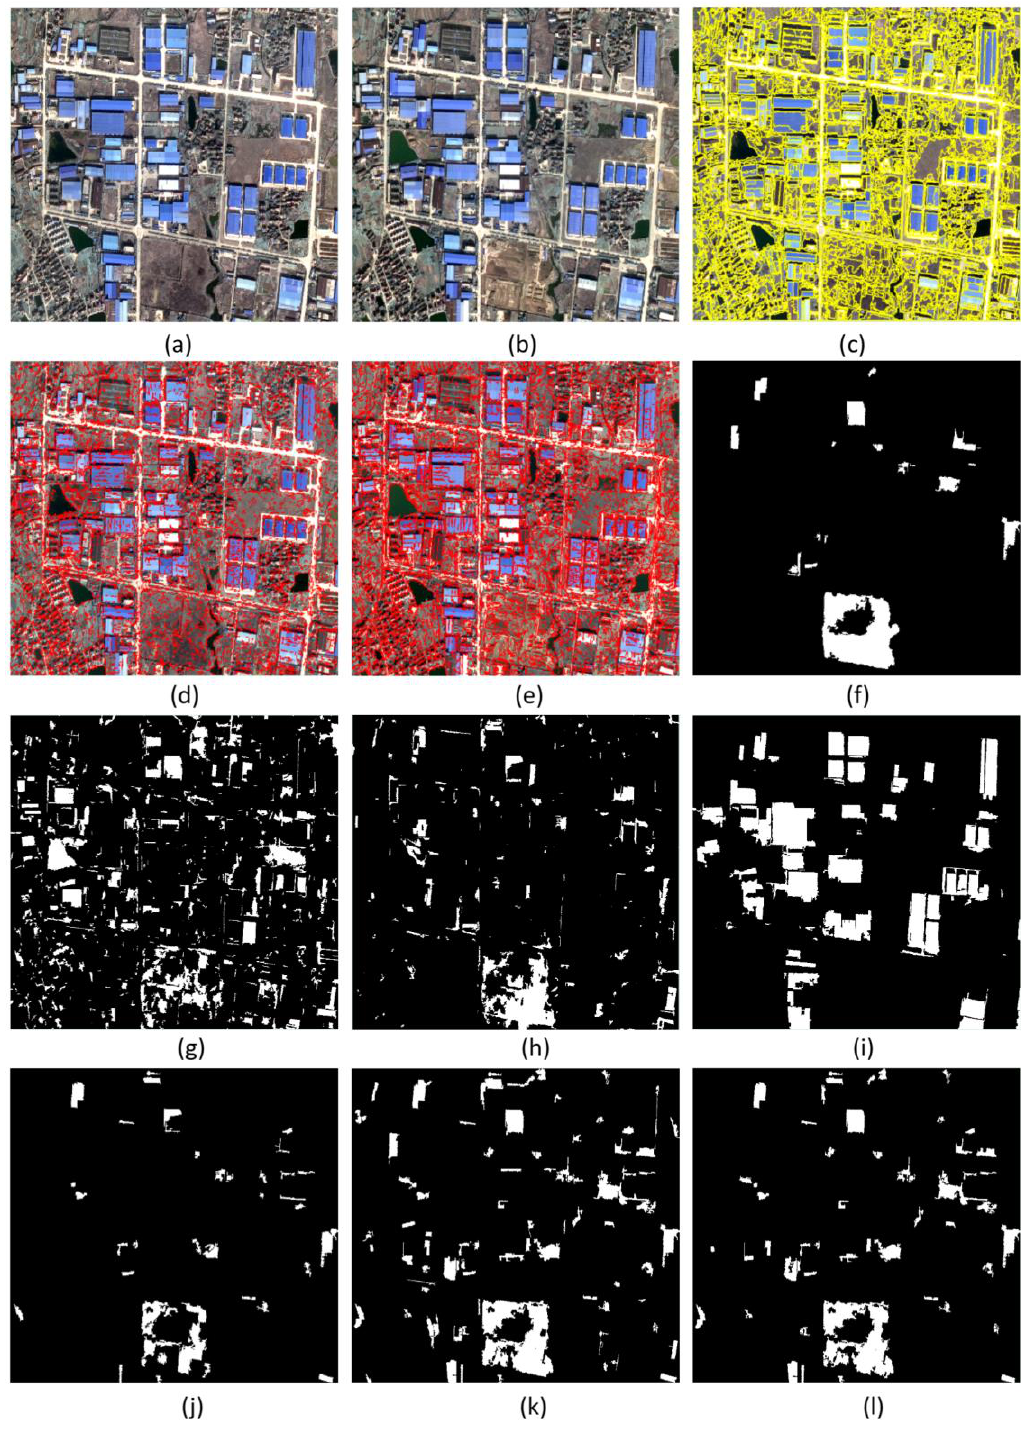
Figure 7. Experimental area 3. ( a , b ) Original bitemporal images. ( c ) TRPs. ( d , e ) TLPs. ( f ) Visual interpretation result. ( g ) Result of CVA. ( h ) Result of PCA-k-means. ( i ) Result of IRMAD. ( j ) Result of initial detection. ( k ) Result of direct threshold relaxation. ( l ) Result after refinement.